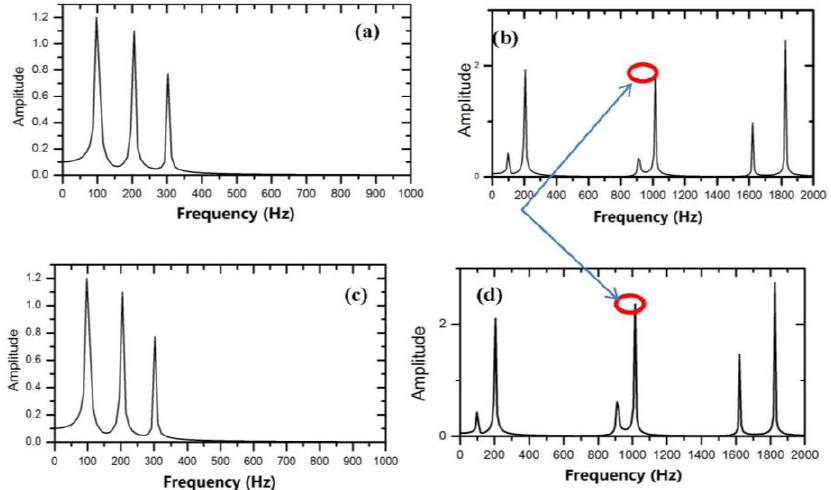
Figure 7. The Volterra series transform for the output signal. ( a , b ) First-order and second-order nuclear output spectra, respectively, when the MOSFET is normal; ( c , d ) First-order and second-order nuclear output spectra, respectively, when the MOSFET is